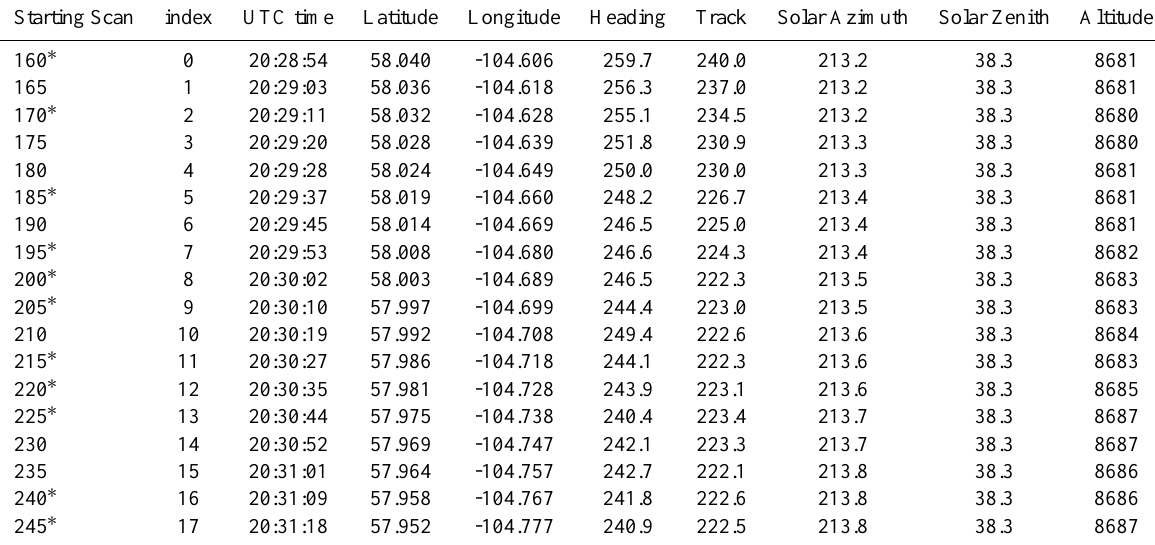
Table A1. Retrieval segment location, time, and solar and instrument geometry. Altitude is in meters above sea level. Optimizations without HSRL data for segments marked with a ∗ were deemed